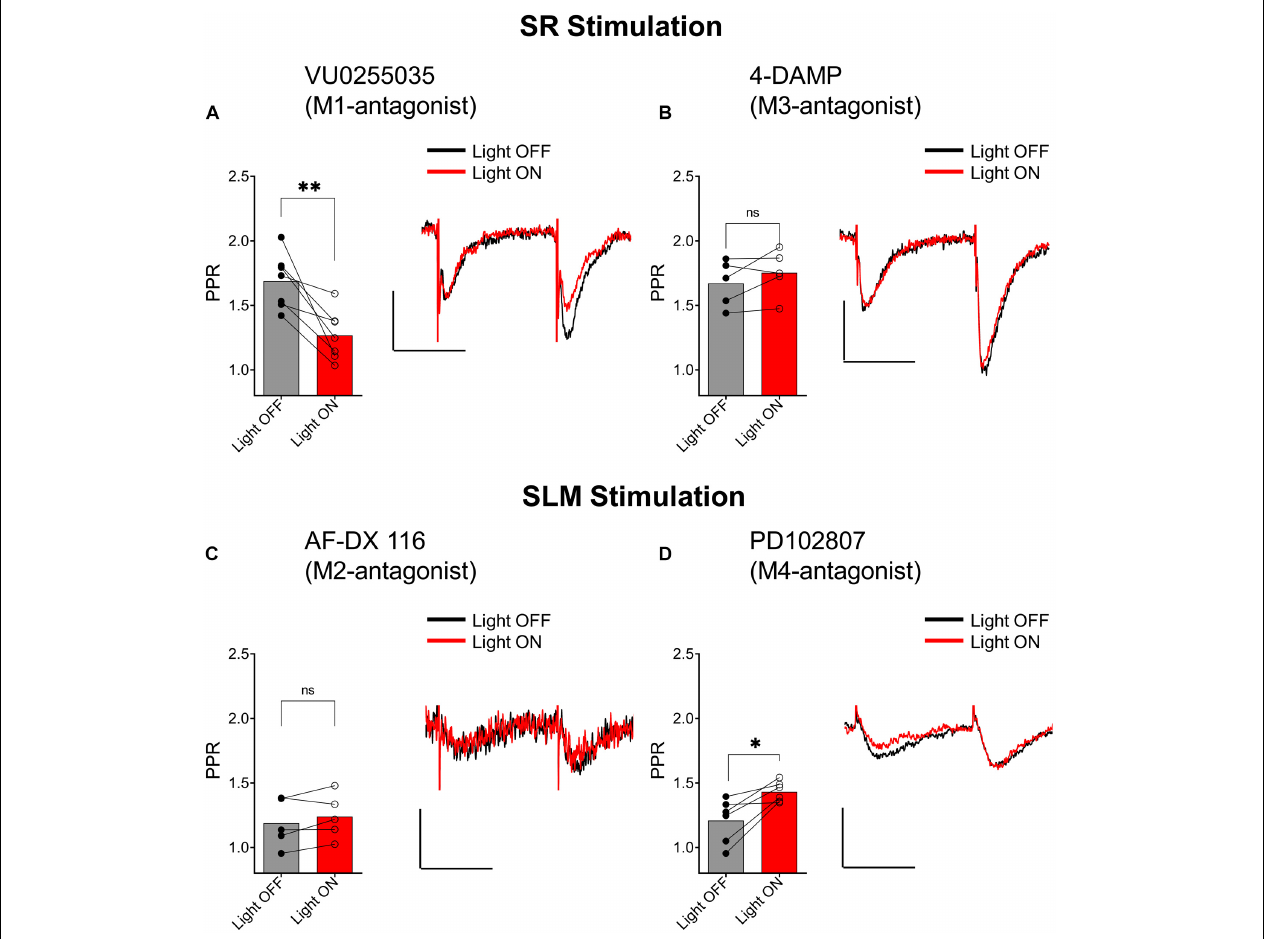
FIGURE 7 | Distinct subtypes of muscarinic receptors mediated the inhibition of EPSCs in the SR and SLM. (A) Bar plot (left) and representative EPSCs (right) demonstrate that VU0255035 (M1 antagonist) had no effect on inhibition of SC EPSCs by ACh release (paired t -test; p = 0.0061). (B) Bar plot (left) and representative EPSCs (right) demonstrate inhibition of SC EPSCs by ACH release is prevented by 4-DAMP (M3 antagonist) (paired t -test; p = 0.2209). (C) Bar plot (left) and representative EPSCs (right) demonstrate that AF-DX 116 (M2 antagonist) prevented ACh-mediated inhibition of SLM EPSCs (paired t -test; p = 0.1984). (D) Bar plot (left) and representative EPSCs (right) demonstrate PD 102807 (M4-antagonist) had no effect on TA EPSC suppression by ACh release (paired t -test; p = 0.0138); Scale bars: x = 20 ms; y = 50 pA.